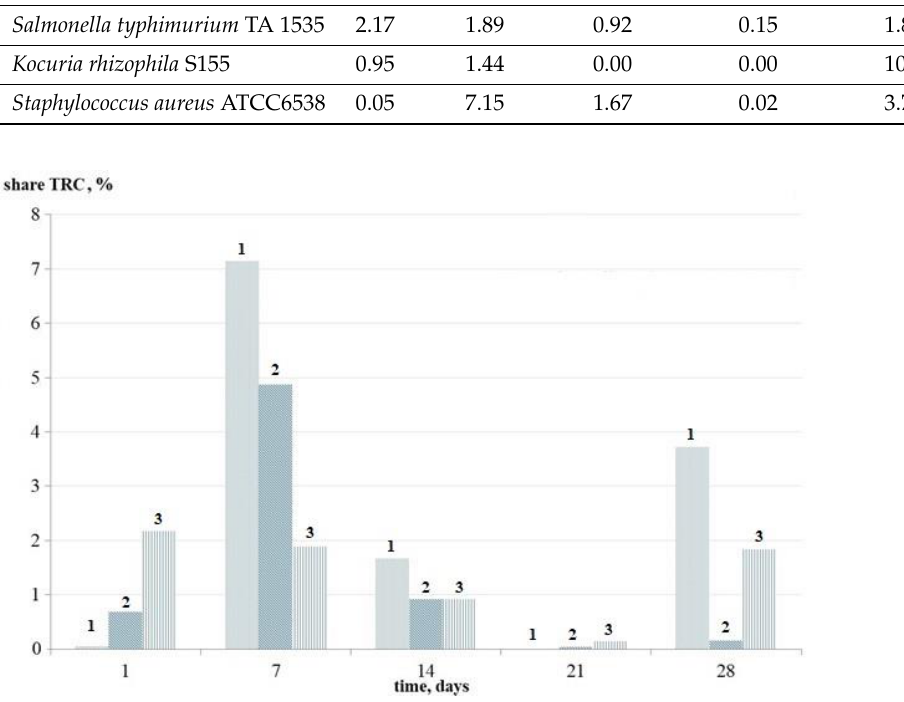
Figure 2. Dynamics of changes in the TRC proportion (%) in the developing periodic planktonic bacterial cultures: 1, S. aureus ; 2, E. coli ; 3, S. typhimurium